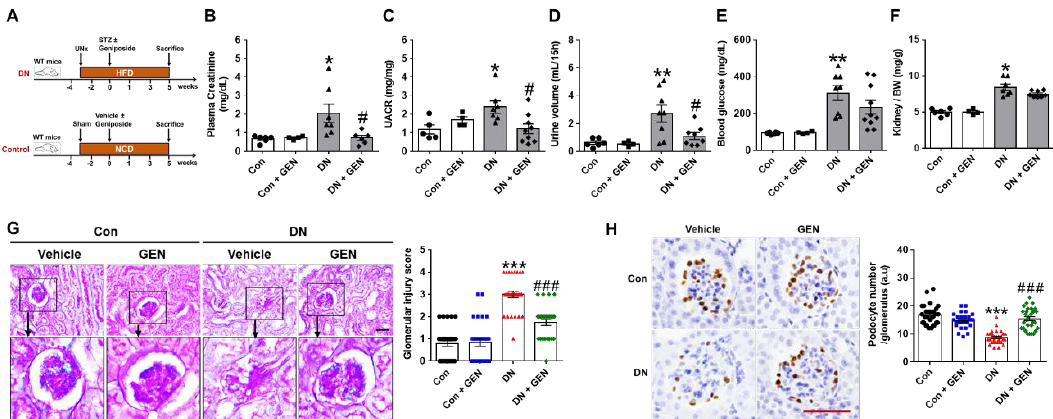
Figure 1. Geniposide decreases albuminuria and renal pathology in diabetic nephropathy (DN). ( A ) DN mouse model was generated by streptozotocin (STZ) injection (100 mg/kg) to the mice after 3 weeks of unilateral nephrectomy (UNx) and high-fat diet (HFD) feeding. After STZ, mice were administered with geniposide (50 mg/kg) or vehicle by oral gavage for 5 weeks. The control mice were fed with a normal chow diet (NCD) and received vehicle or geniposide. At sacrifice, the blood and urine samples were collected from each group. ( B ) Plasma creatinine, ( C ) urine albumin to creatinine ratio (UACR), ( D ) urine volume (mL/15 h), ( E ) blood glucose and ( F ) kidney/body weight (BW) ratio were analyzed, respectively (Control (Con) or Control + geniposide (Con + GEN), n = 4–6; DN or DN + GEN, n = 7–10). ( G ) Kidney sections were processed for PAS staining, representative images were shown, and glomerular morphological changes were scored, as described in the method ( n = 3–5). ( H ) Kidney sections were processed for WT1 immunostaining; representative images are shown and the number of stained podocytes per glomerulus was counted using ImageJ software ( n = 3–5). Data are presented as the mean ± SEM. One-way ANOVA was used for statistical analysis followed by Bonferroni’s multiple comparisons. * p < 0.05, ** p < 0.01, *** p < 0.001 vs. control mice; and # p < 0.05, ### p < 0.001 vs. DN mice. Scale bar, 50 µm.